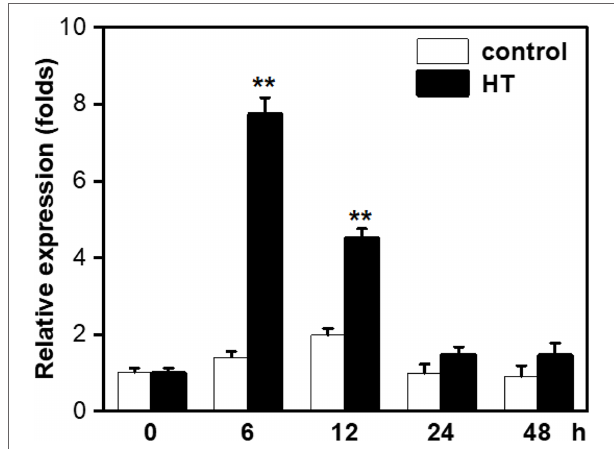
FIGURE 2 | Expression of GlSPDS in response to high temperature (HT) stress. Algal samples with HT treatment and control treatment in an incubator were collected at indicated time points for analysis of gene expression. 18S Actin was used as an internal reference gene and relative expression was shown as folds of the transcript value of the 18S Actin gene. Data presented are the means ± standard errors (SE) from three independent